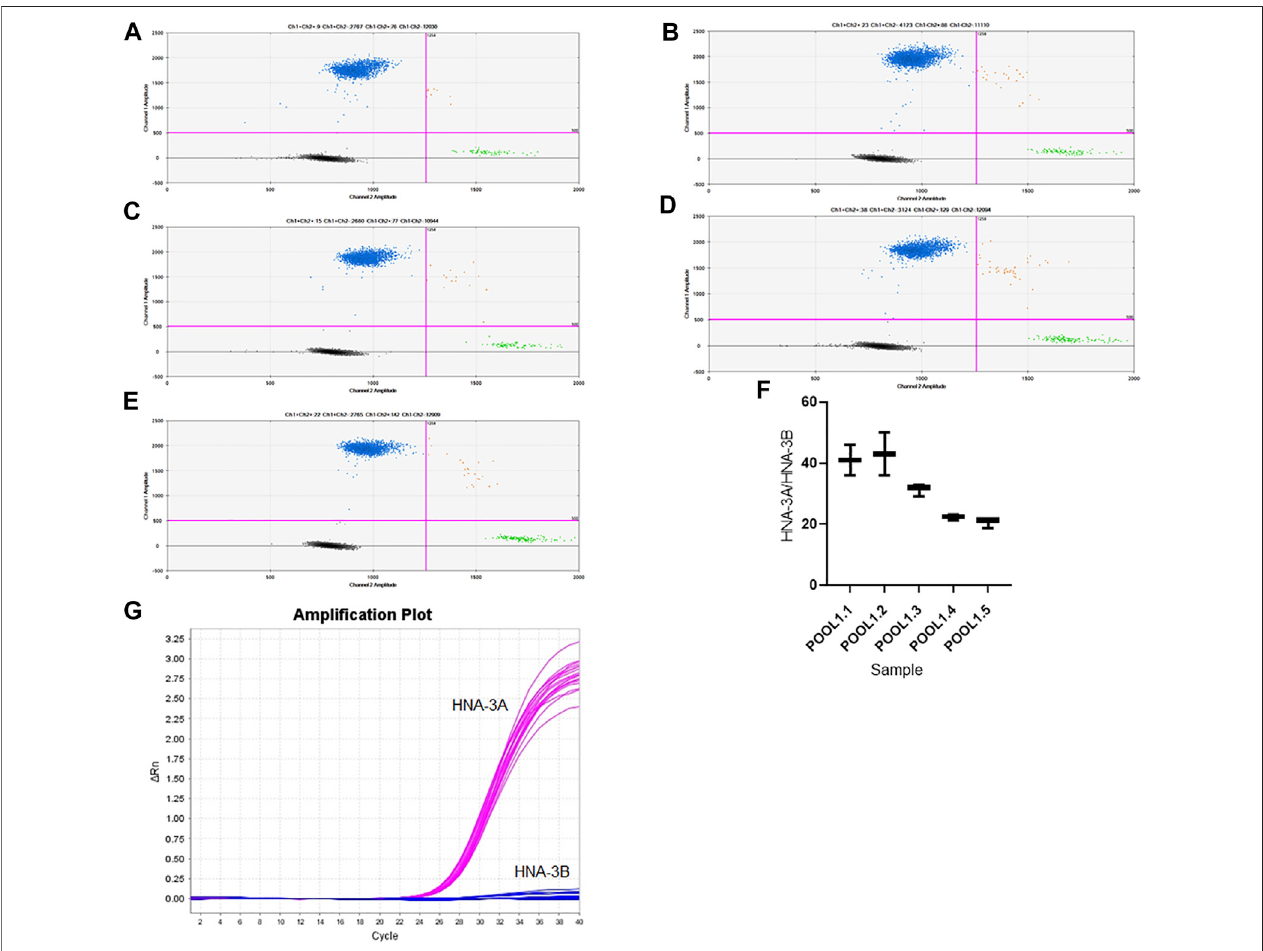
FIGURE 3 | Visualization of the 2D projection of the droplets from the QuantaSoft software. The vertical axis shows the Channel 1 amplitude and horizontal axis shows theChannel2amplitude. (A) Pool1included oneHNA-3*A/*Band 49HNA-3*A/*Adonors; ( B)Pool2included twoHNA-3*A/*B and48HNA-3*A/*A donors; (C) Pool 3 included 3 HNA-3*A/*B and 47 HNA-3*A/*A donors; (D) Pool 4 included 4 HNA-3*A/*B and 46 HNA-3*A/*A donors; (E) Pool 5 included 5 HNA-3*A/*B and 45 HNA-3*A/*A donors; (F) Concentration ratios of channel 1 (FAM) to channel 2 (VIC); (G) Ampli fi cation Plot of HNA-3A (pink) and HNA- 3B (blue) by TaqMan real- time